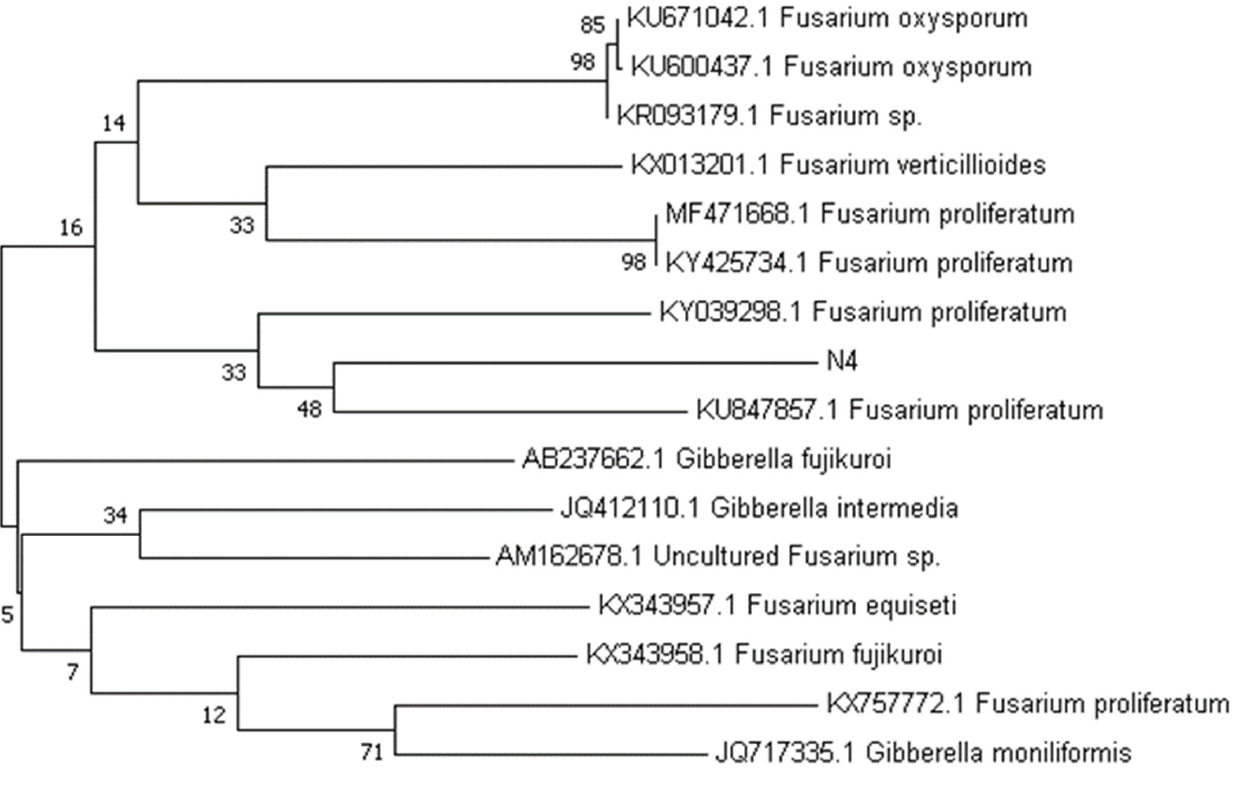
Figure 2. Identification of fungal isolate N4 by phylogenetic analysis. Neighbor joining tree (550 bootstrap replications) was constructed using 16 taxa. Bootstrap support of 48% for subclade of N4 with Fusarium proliferatum strongly suggests this fungal isolate as a new strain of Fusarium proliferatum (KU847857.1).